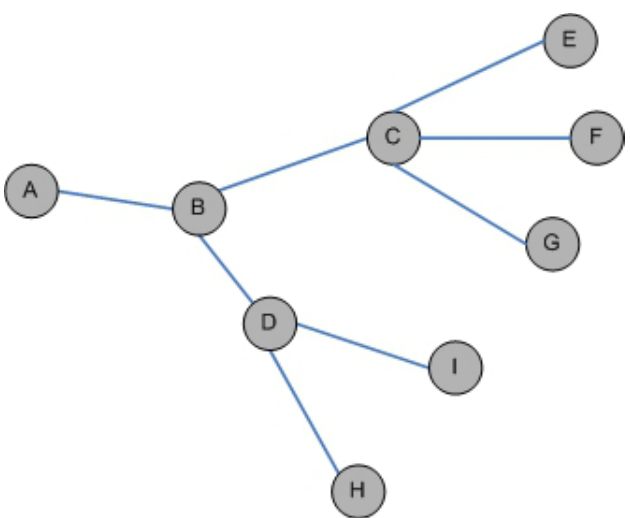
Figure 5. Configuration used for comparing Z-MAC and